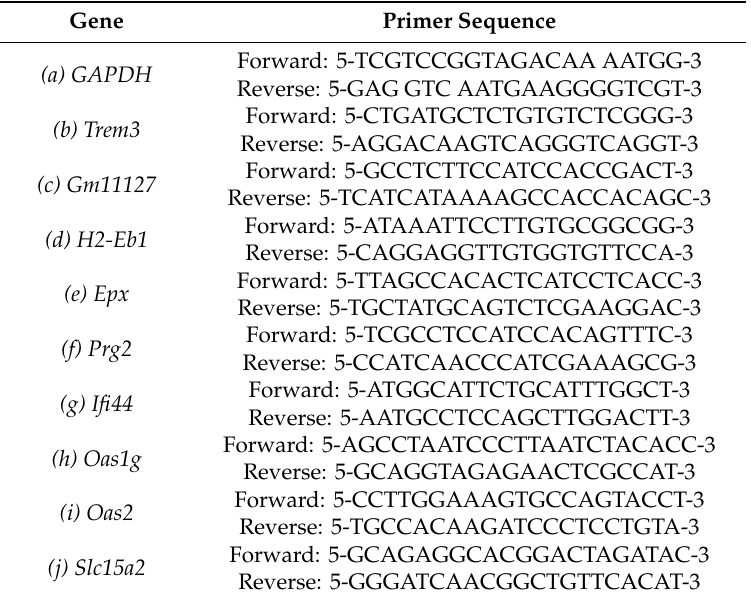
Table 1. Sequences of primers for quantitative RT-PCR. Gene Primer